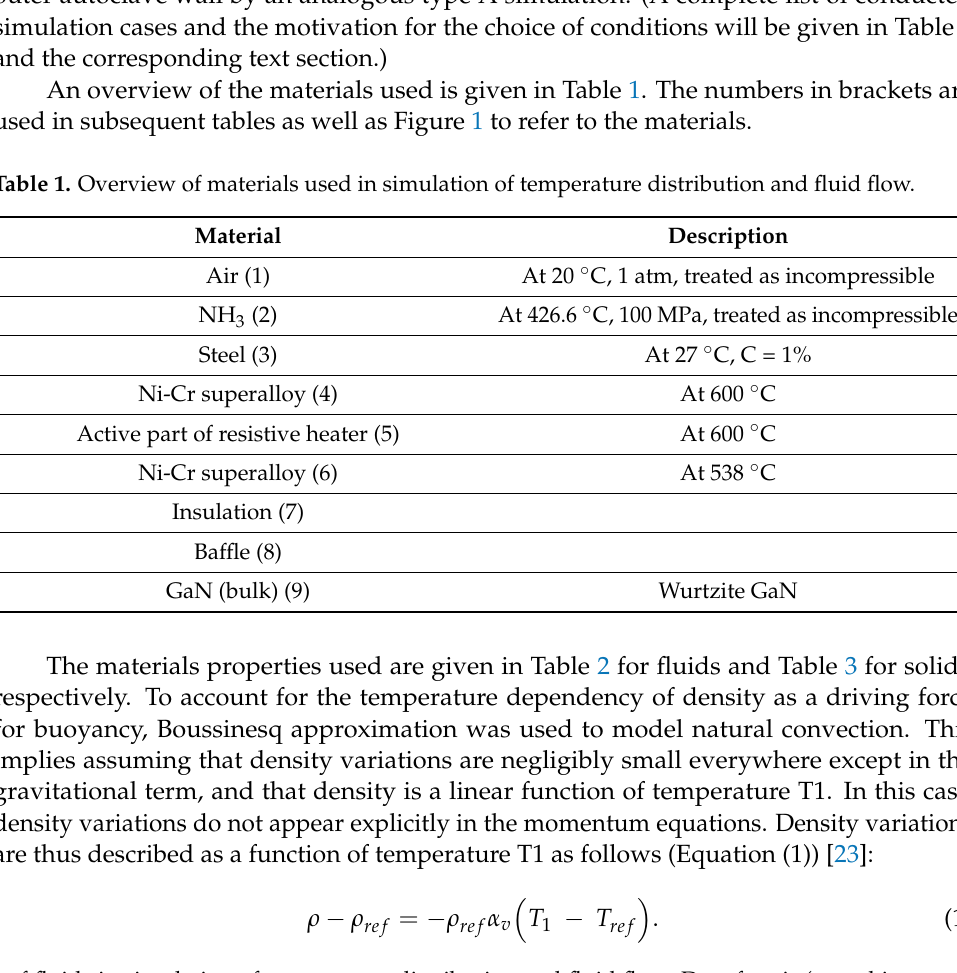
Table 2. Material properties of fluids in simulation of temperature distribution and fluid flow. Data for air (at ambient temperature) were taken from Phoenics inbuilt database, data for supercritical ammonia at 426.9 ◦ C (the upper end of the temperature range for which data are available) were obtained from NIST database [24].